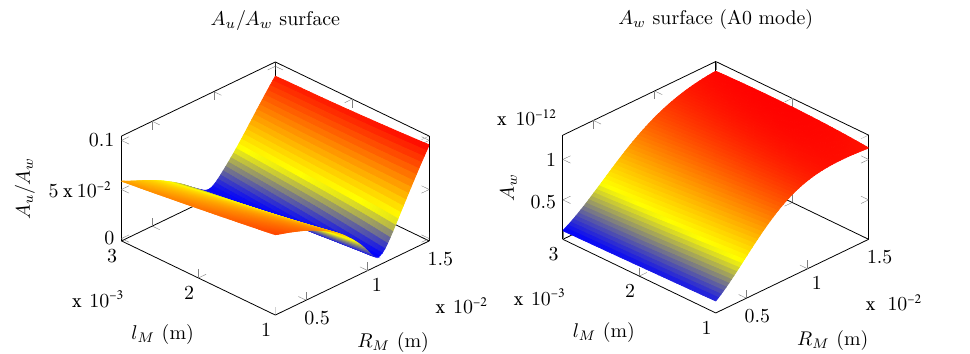
Figure 9. A u /A w and A w surfaces predicted with the MLP with LM algorithm.